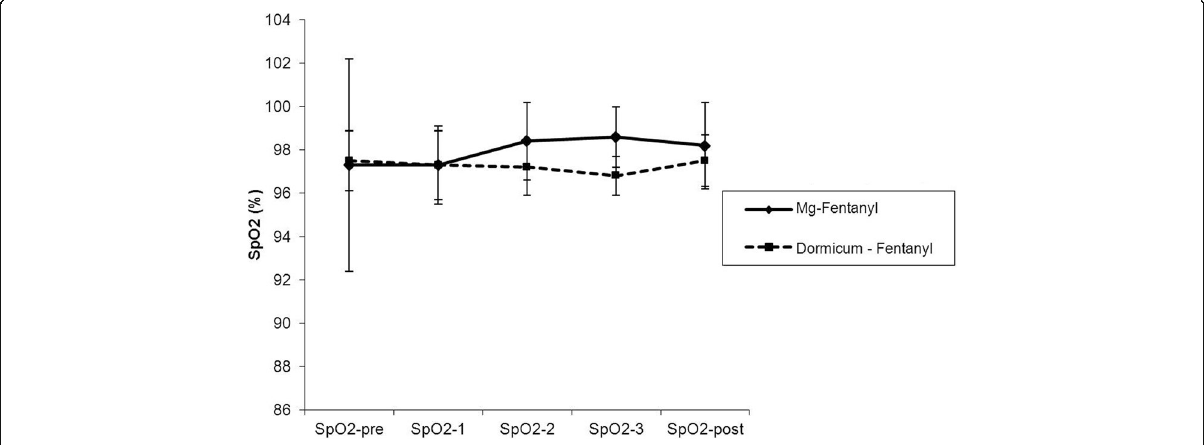
Fig. 4 Changes in arterial oxygen saturation (SpO 2 ) in both study groups. Markers represent means and error bars represent 95%